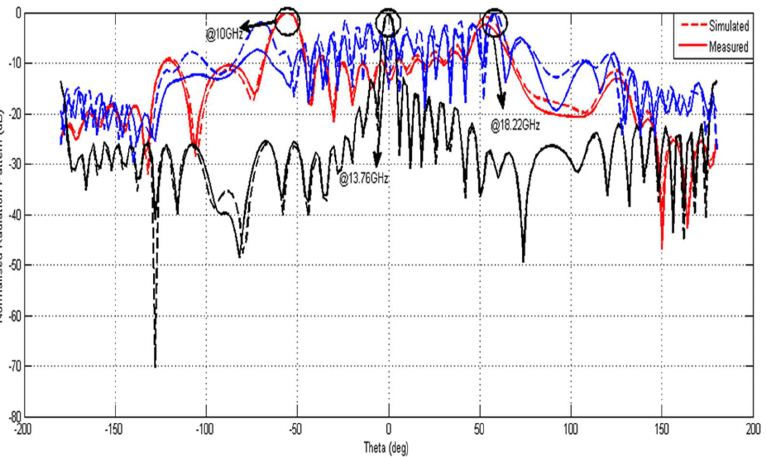
Figure 7. Simulated and measured radiation patterns (y-z plane) for proposed SIW LWA